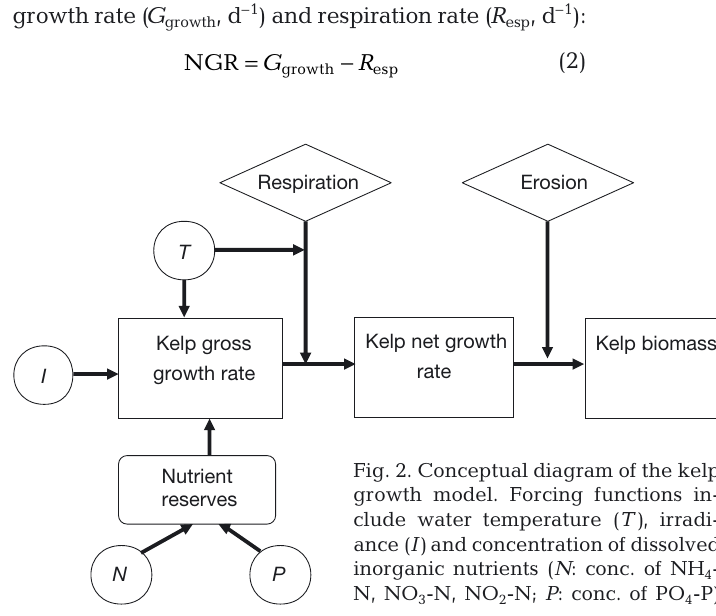
Fig. 2. Conceptual diagram of the kelp growth model. Forcing functions